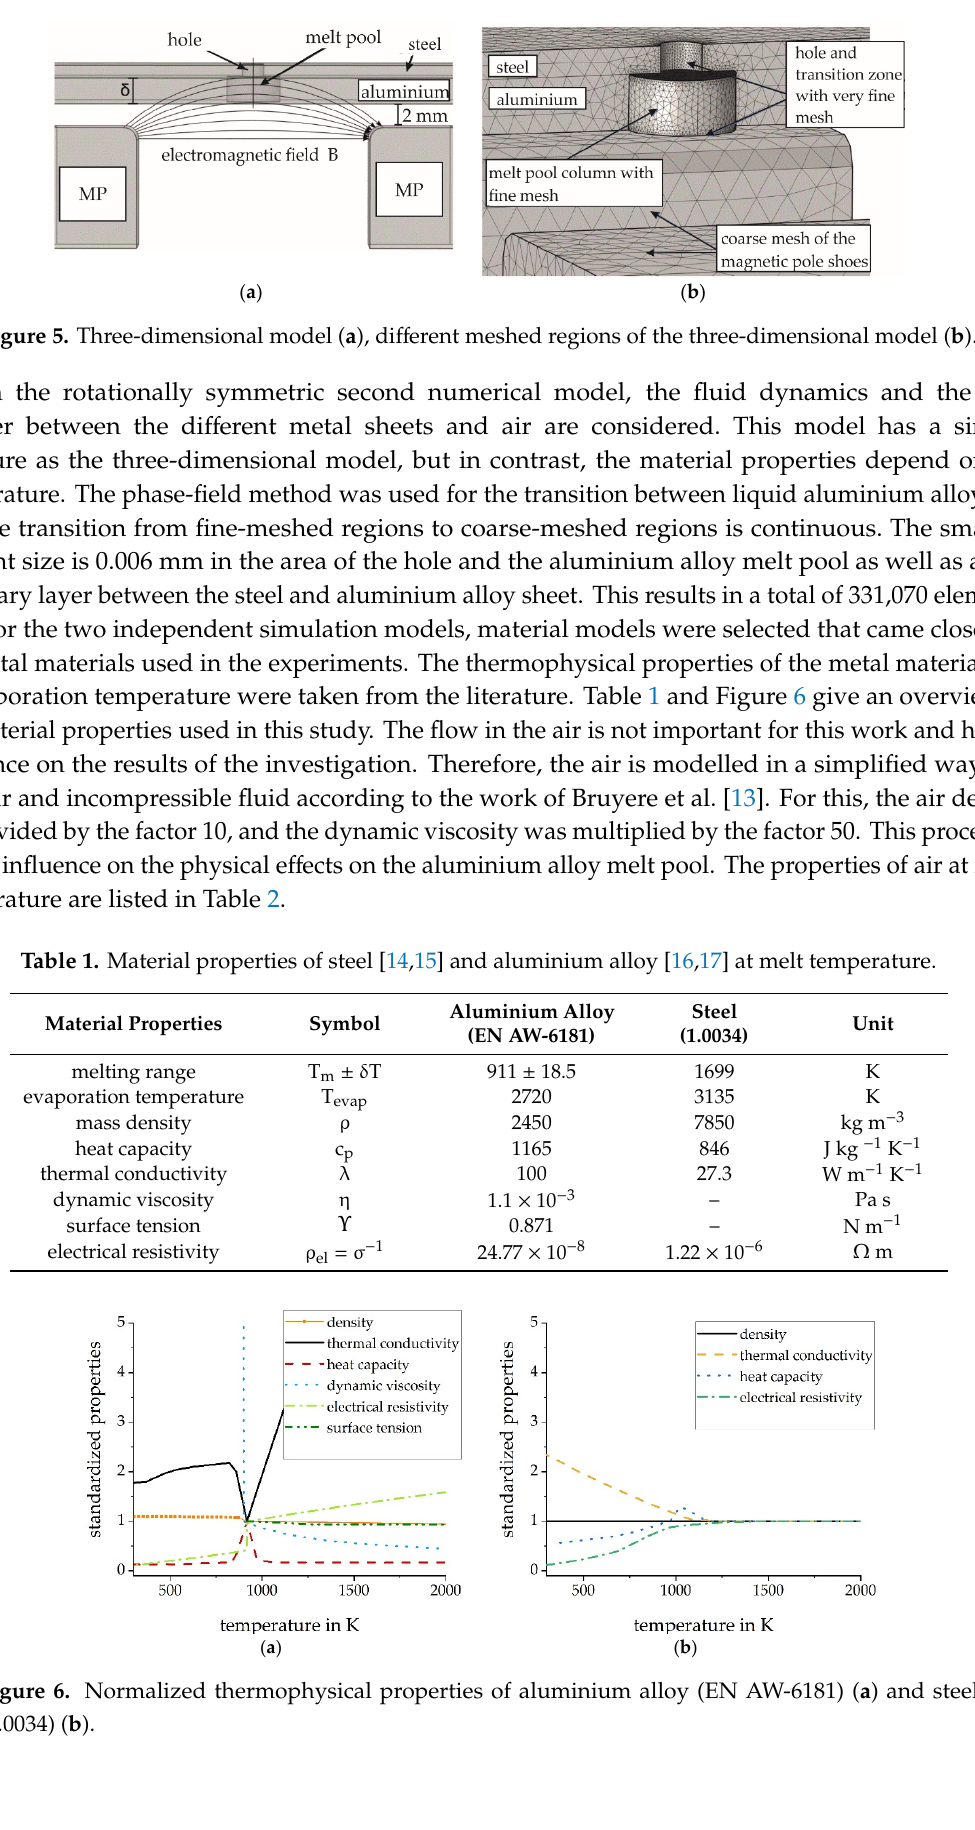
Figure 6. Normalized thermophysical properties of aluminium alloy (EN AW-6181) ( a ) and steel (1.0034) ( b ). Volume heat sources are used for deep-penetration welding. The heat source used in this study